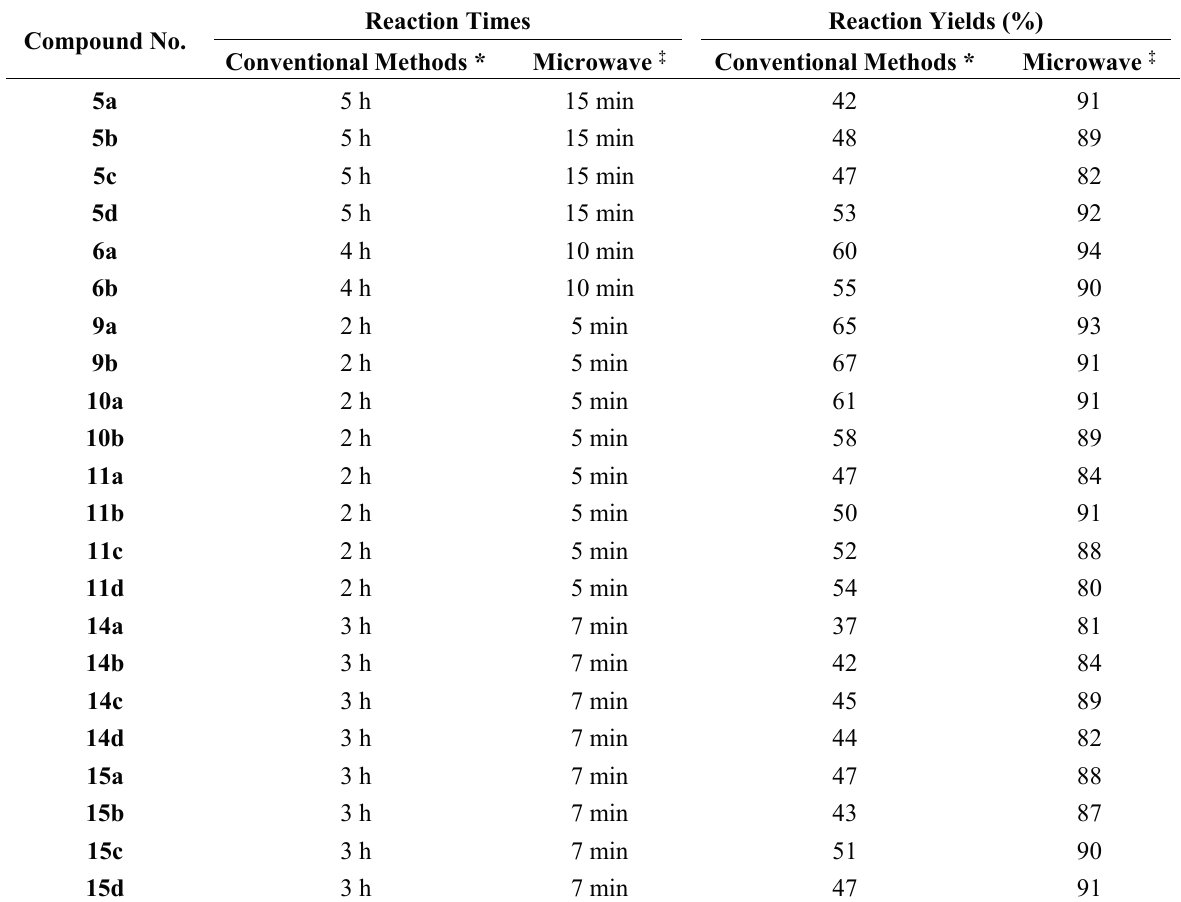
Table 1. Comparison between conventional methods and microwave assisted methods of synthesis of compounds 5a – d , 6a , b , 9a , b , 10a , b , 11a – d , 14a – d and 15a – d . Compound